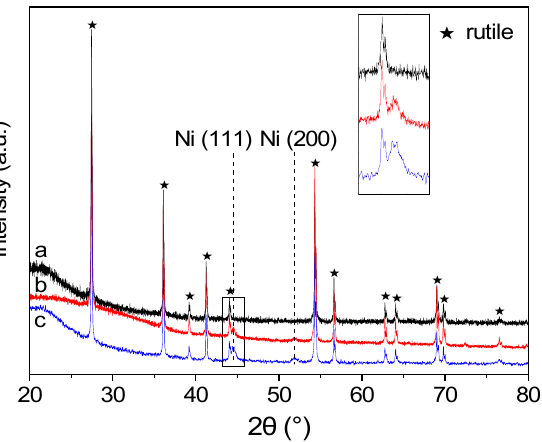
Figure 1. XRD patterns of 650 °C reduced ( a ) 1Ni/r-TiO 2 , ( b ) 5Ni/r-TiO 2 , and ( c ) 10Ni/r-TiO 2 . H 2 -TPR is used to probe the interaction between Ni and rutile TiO 2 . As shown in Figure 2, the bare rutile TiO 2 consumes few H 2 at high reduction temperatures. A reduction peak at 494 °C is observed for 1Ni/r-TiO 2 , which is attributed to the reduction of small Ni particles strongly interacting with r-TiO 2 . As the amount of Ni loading is increased, another peak emerges at lower temperatures, which can be ascribed to the reduction of larger Ni particles with weaker interaction with r-TiO 2 . This peak increases in intensity and shifts to lower temperatures from 387 to 378 °C with increasing Ni loadings from 5% to 10%, indicating larger NiO particles are present for 10Ni/r-TiO 2 . The quantified hydro- gen consumption is summarized in Table 1. It is evident that the H 2 /Ni molar ratio is higher than 1 for all samples, indicating besides the complete reduction of NiO, the r-TiO 2 support is also partially reduced. This phenomenon is related to the spillover of H from metallic Ni to TiO 2 support, resulting in a partial reduction of TiO 2 in proximity to Ni. It is important to note that the H 2 /Ni molar ratio is the highest on 1Ni/r-TiO 2 (1.41) and de- creases with increasing Ni loadings, which suggests that a smaller Ni particle favors more H 2 spillover due to high Ni dispersion.